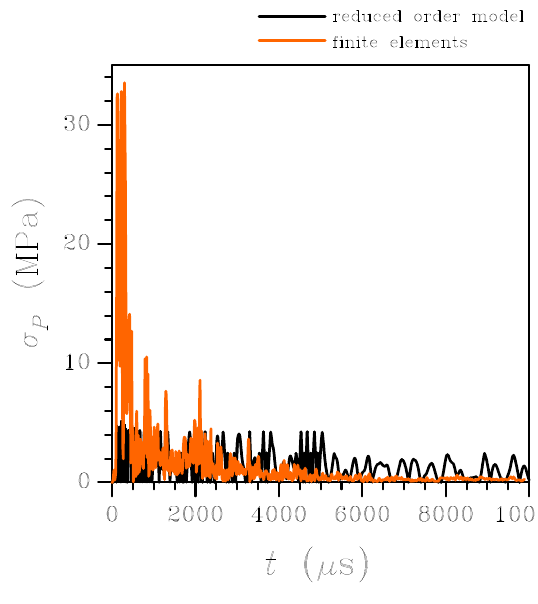
Figure 8. High- g test: time evolution of the maximum principal stress in the plate-spring connection region. Comparison between FE and ROM